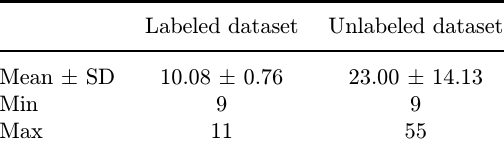
Table 2. Number of data points. Labeled